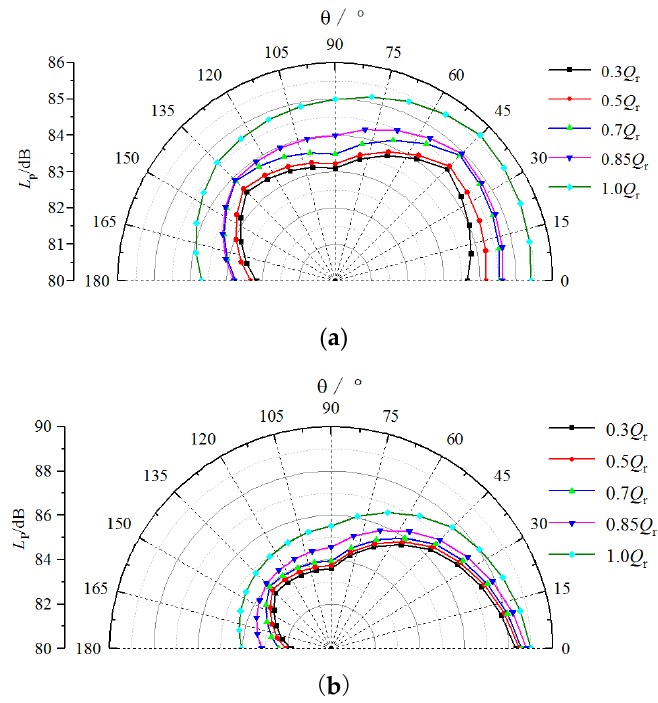
Figure 10. Half directivity characteristics curves of radiated noise at different operating conditions: ( a ) vertical direction ; ( b ) skew 45 ° direction .